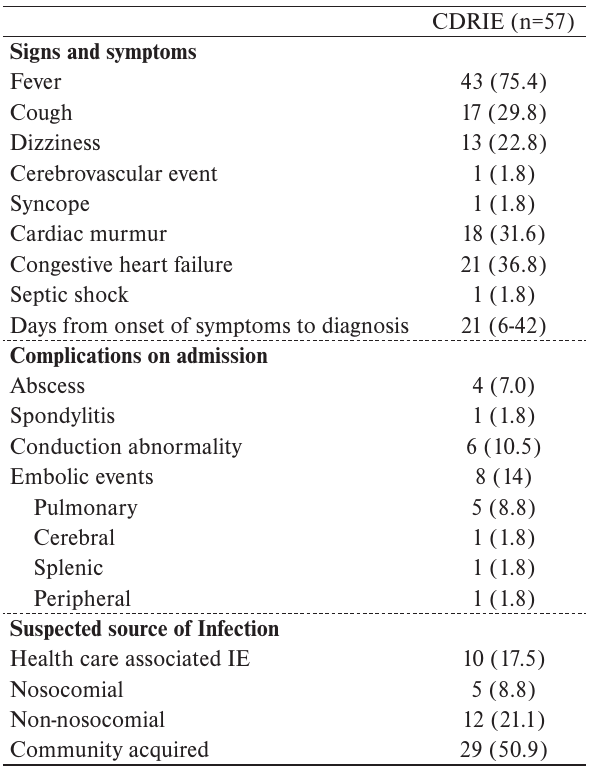
Table 2. Clinical presentation.